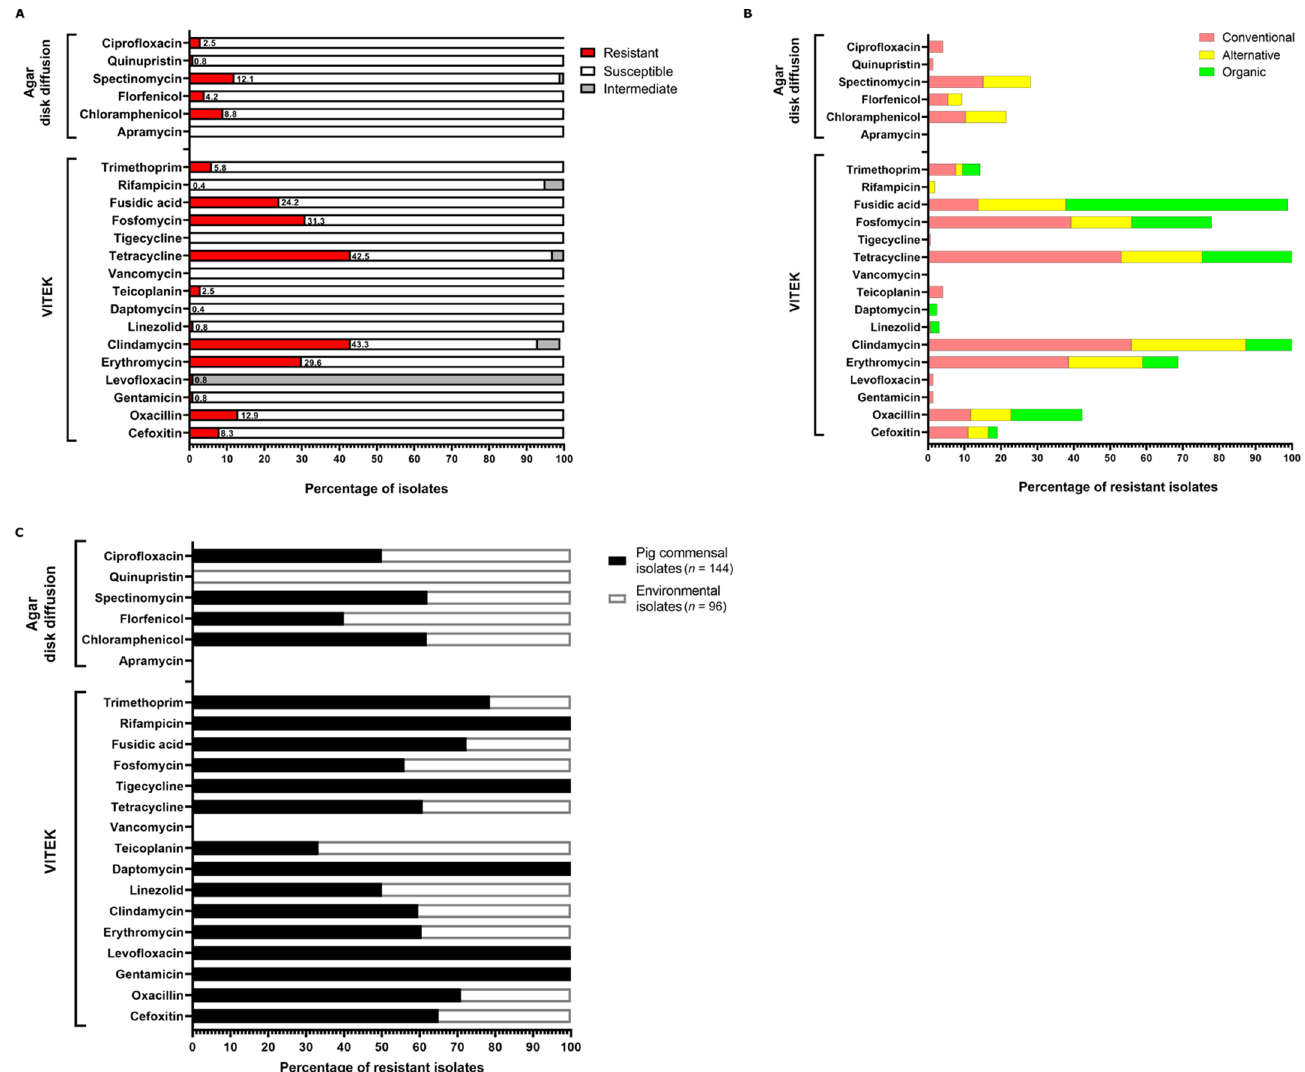
Figure 2. Phenotypic antibiotic resistance determination by VITEK and agar disk diffusion. ( A ) Resistance profile of all NAS isolates ( n = 240). The percentage of resistant (red), susceptible (white), and intermediate (grey) isolates are represented by the x-axis ( B ) The assignment of the resistant isolates to the individual farm types is shown in a bar chart: conventional (red), alternative (yellow), and organic (green). ( C ) Categorisation of resistant isolates according to their site of sampling, as either pig commensal isolates (black bar) or environmental isolates (white bar).